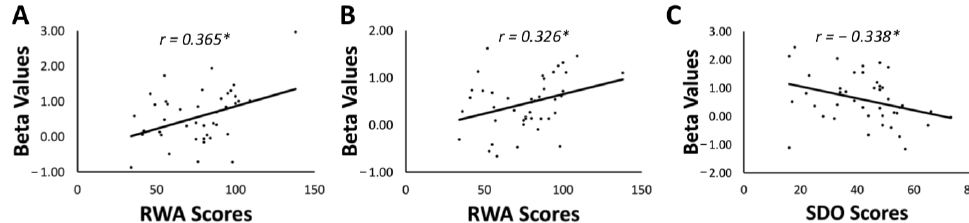
Figure 2. ( A ) Correlation between beta values in the right postcentral gyrus [MNI coordinates (39, − 31, 38)] for the contrast Chinese > Arabic + Indian + Caucasian faces and participants’ scores in the Right Wing Authoritarianism (RWA) scale. ( B ) Correlation between beta values in the right caudate [MNI coordinates (27, − 37, 5)] for the contrast Chinese > Arabic faces and participants’ RWA scores. ( C ) Correlation between beta values in the right middle occipital gyrus [MNI coordinates (36, − 70, 2)] for the contrast Chinese > Arabic + Indian + Caucasian faces and participants’ scores in the Social Dominance Orientation (SDO) scale. * p <